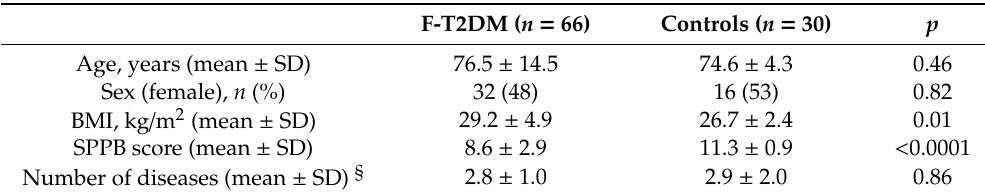
Table 1. Main characteristics of study